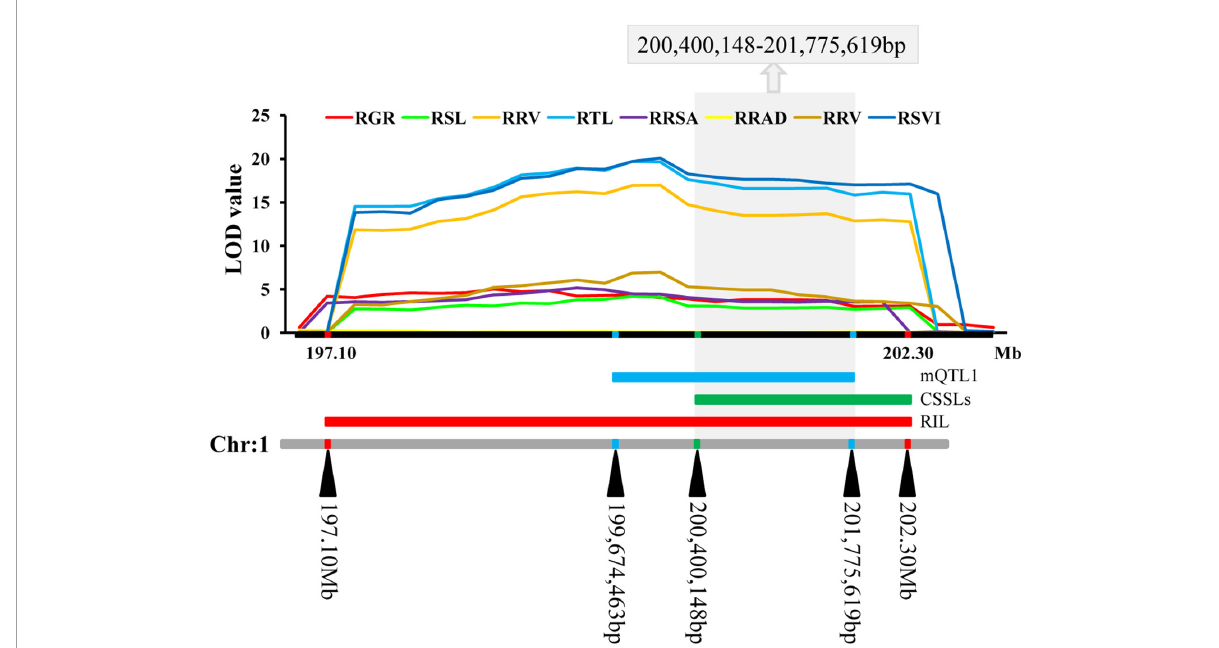
FIGURE5 The consistent segments during the germination related to low-temperature. For each trait, different colors of LOD value represent the eight different traits related to low-temperature tolerance (RGR, RSL, RRL, RTL, RRSA, RRAD, RRV, and RSVI).